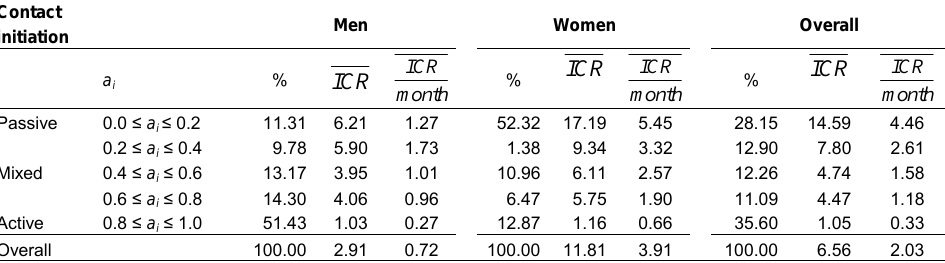
Table 6 : Contact initiation activity by sex and frequency of incoming contact offers Contact Men Women Overall initiation % ICR